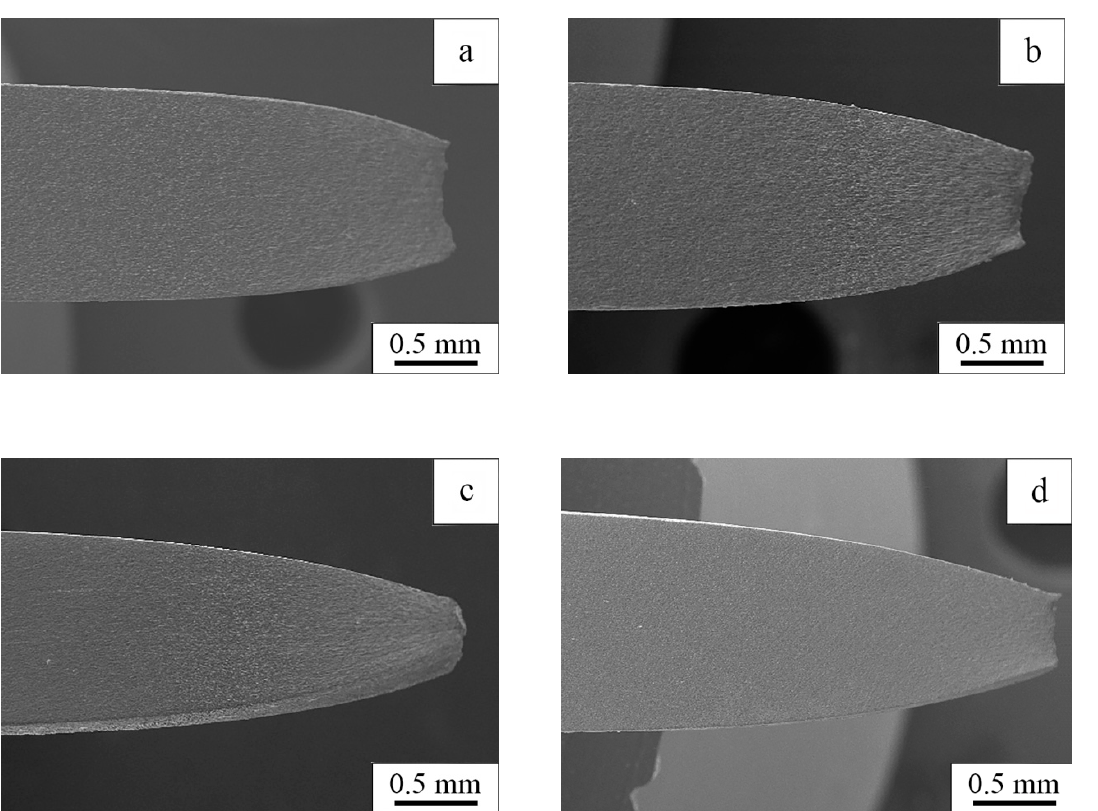
Figure 9. Fracture area of samples of the ( a ) FG Zr–1Nb, ( b ) FG Zr–1Nb–0.33H, ( c ) UFG Zr–1Nb, and ( d ) UFG Zr–1Nb–0.33H alloys after tension at 873 K.